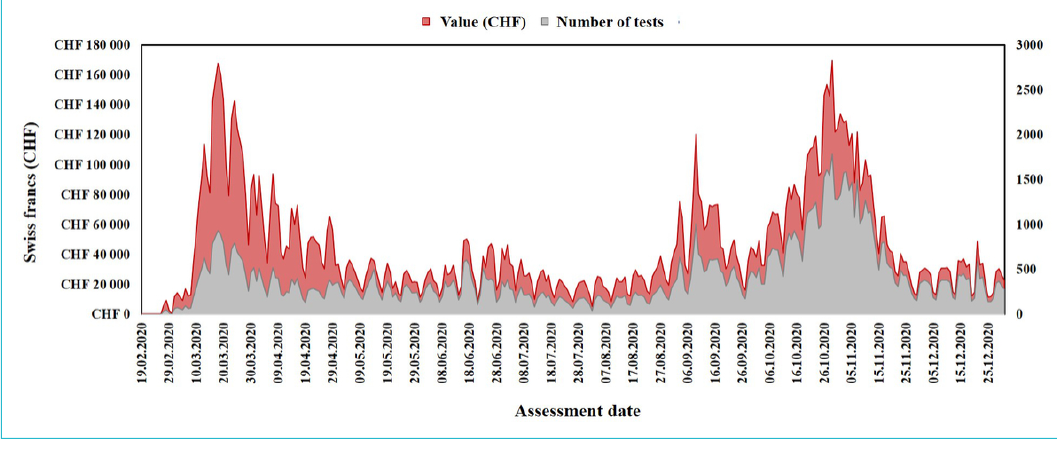
Figure 2: Laboratory reimbursements for SARS-CoV-2 RT-PCR tests compared to the number of tests performed throughout 2020 at Lau- sanne University Hospital (Switzerland). The evaluation starts after 14 February 2020, when SARS-CoV-2 RT-PCR first became available at our institute. Data were collected per 10 days